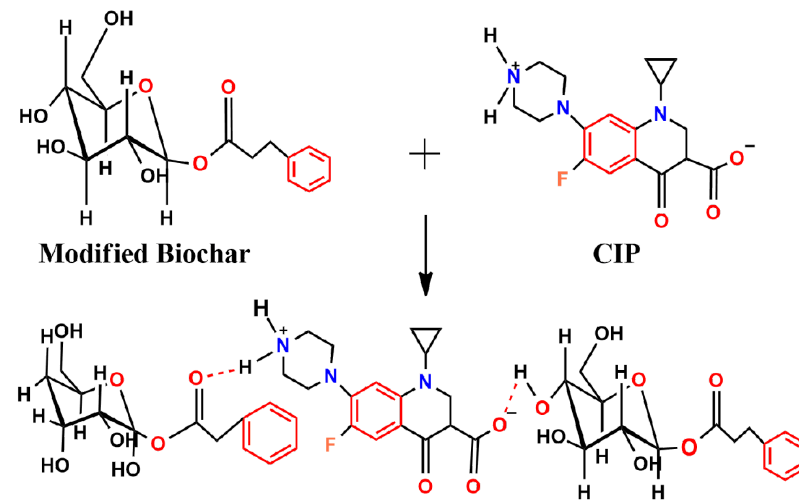
Figure 11. Interaction of CIP in neutral form with modified biochar.